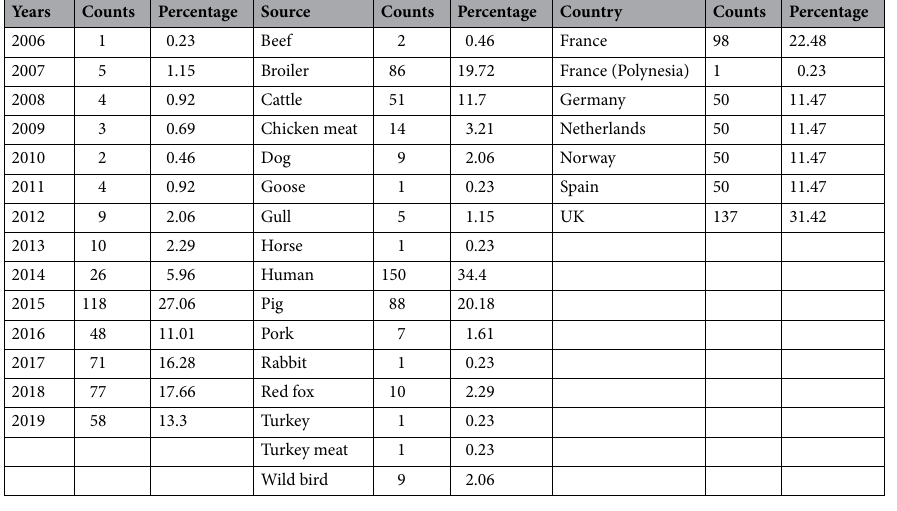
Table 1. Distribution of the 436 E. coli isolates by year, source, and country. All human isolates were of clinical origin, whilst the animal isolates were from healthy animals; meat isolates were assumed to be from healthy animals as they had entered the food